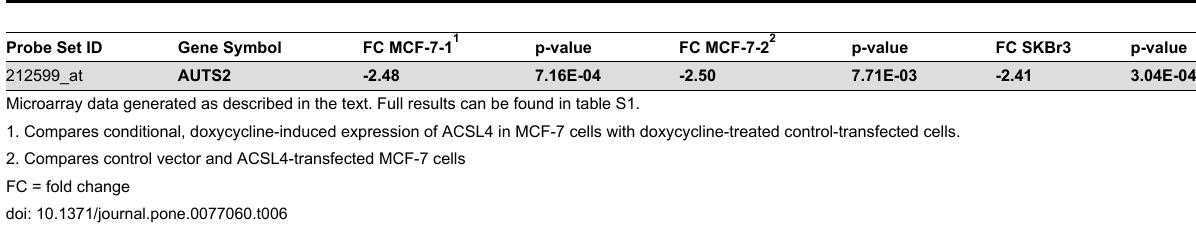
Table 6. Shared affected genes: Comparison across all three experiments.